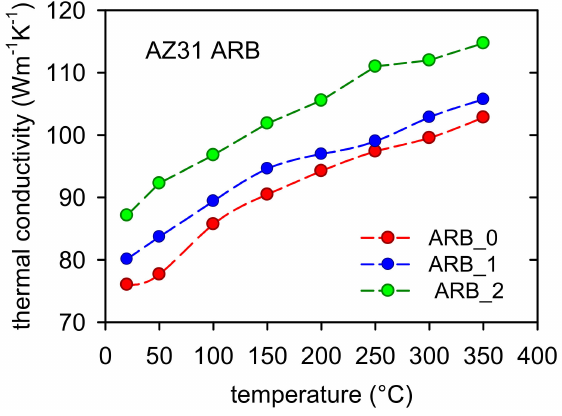
Figure 5. Temperature dependence of thermal conductivity.